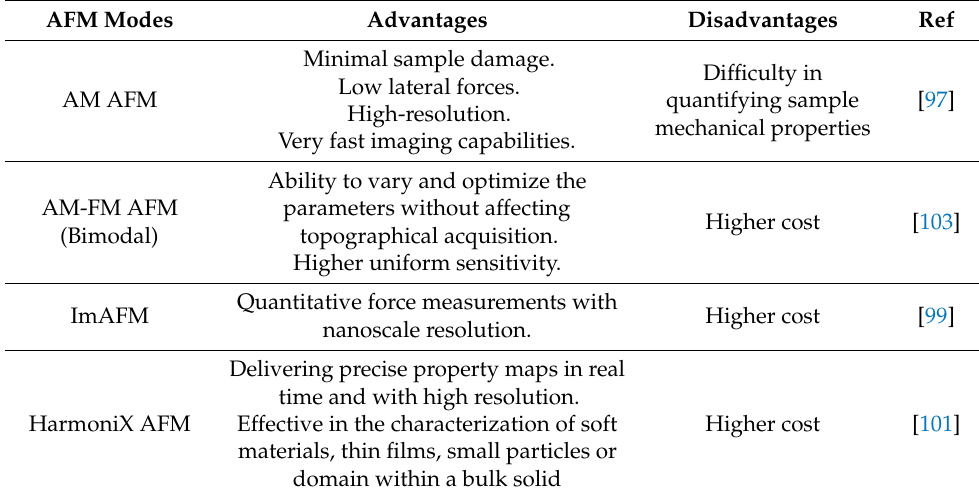
Table 2. AFM modes for characterization of polymer nanocomposites with their advantages and